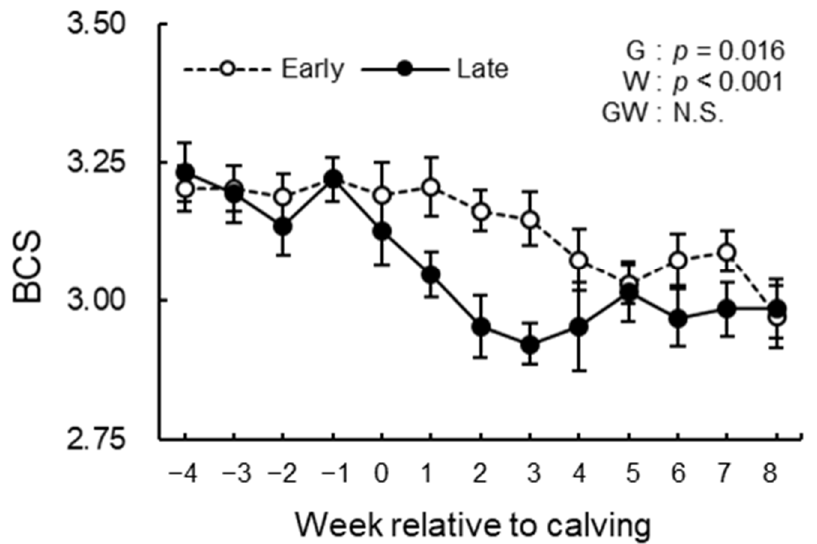
Figure 4. BCS from −4 to 8 wk relative to calving for cows classified into the early group (Early) and the late group (Late). Early = cows with endometrial inflammation converged within 4 wk, n = 17; Late = cows with endometrial inflammation converged at or after 5 wk, n = 16. The week of calving is defined as 0 wk. G = group effect; W = week effect; GW = group-by-week interaction. Data are shown as mean ± SEM.